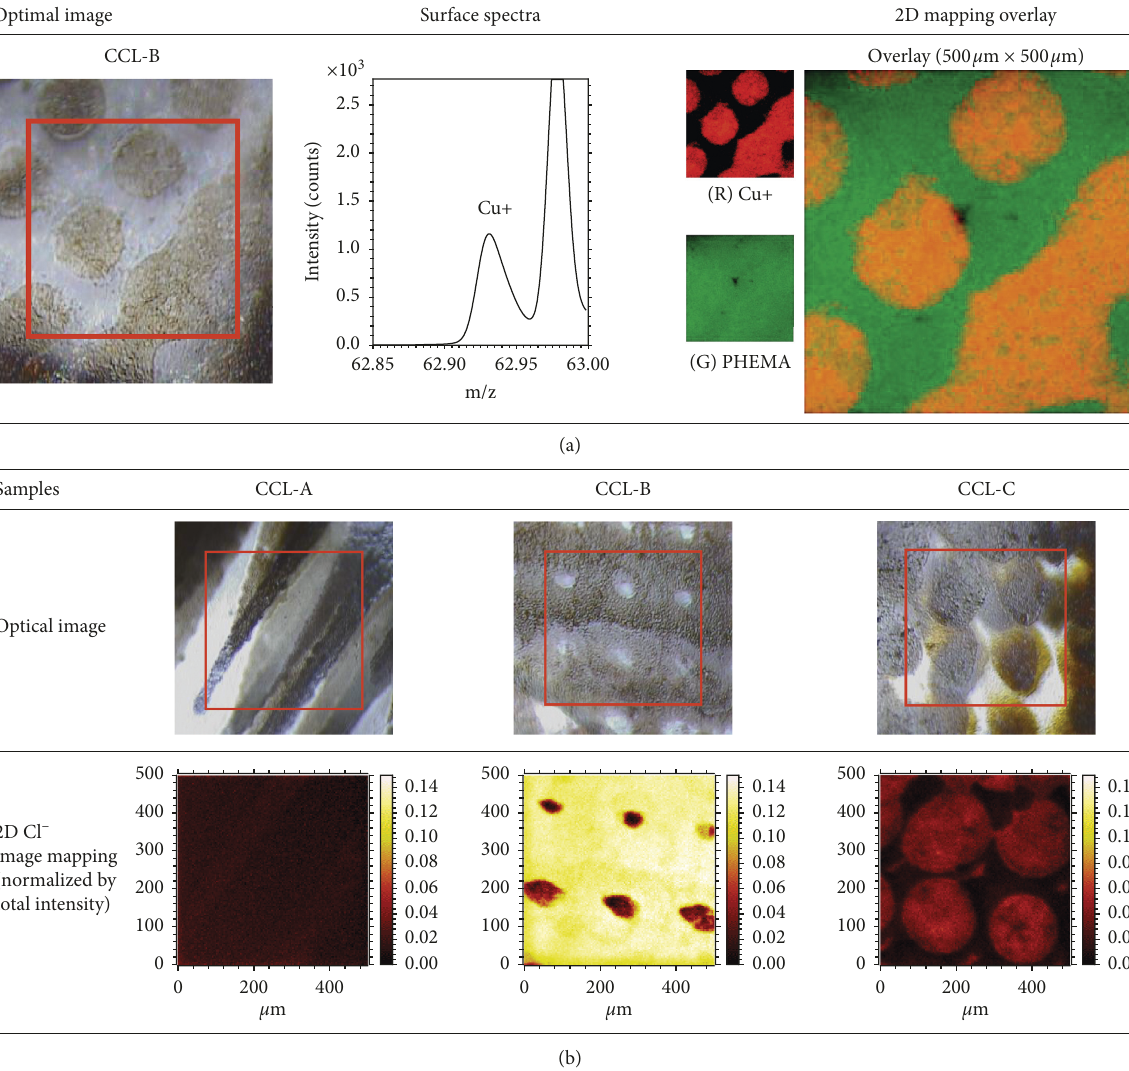
Figure 5: Optical images of the analysis area and ToF-SIMS 2D image mapping on the front surface of the colored part. (a) Overlay image of Cu + and PHEMA for CCL-B. (b) Cl − mapping images normalized by total intensity for lenses CCL-A, CCL-B, and